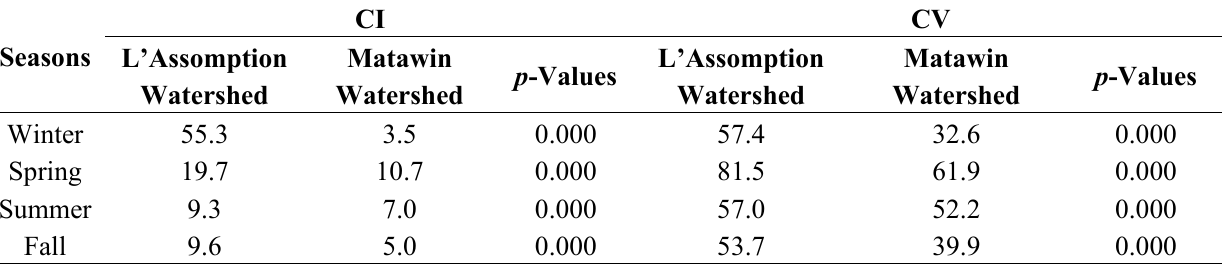
Table 1. Comparison of mean values of coefficient of immoderation (CI) and the coefficient of variation (CV) using the paired t test